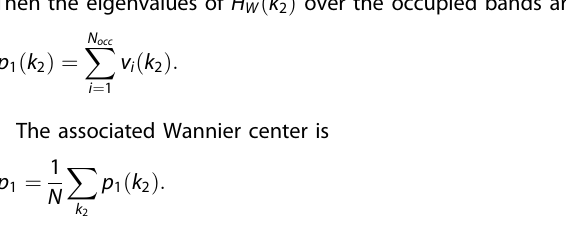
white arrows in Fig. 3b, c are identi fi ed to be fi rst-order helical edge states under the introduction of spin-orbit coupling (SOC)